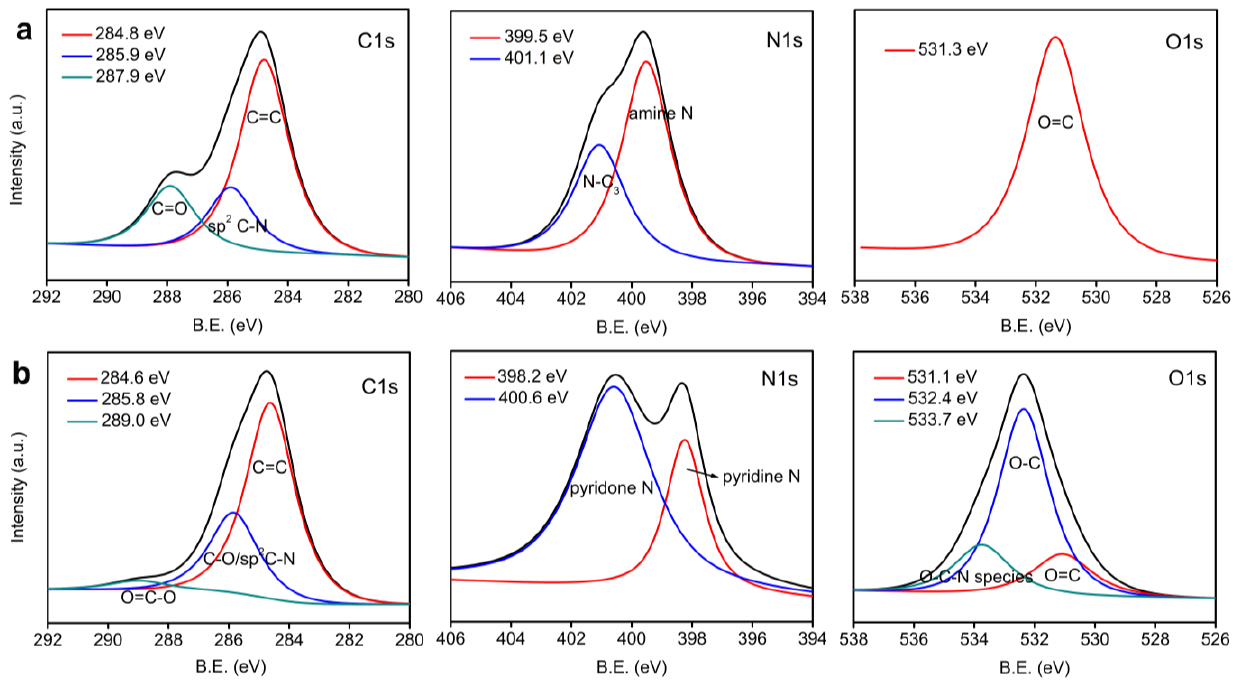
Figure 4. XPS spectra of polyimide film ( a ) and CNF ( b